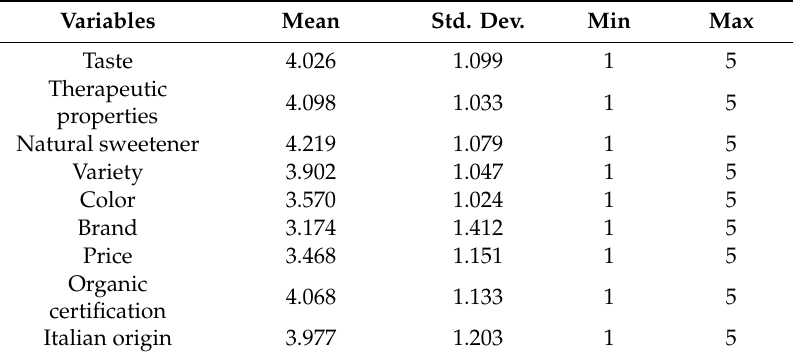
Table 1. Variables of honey quality